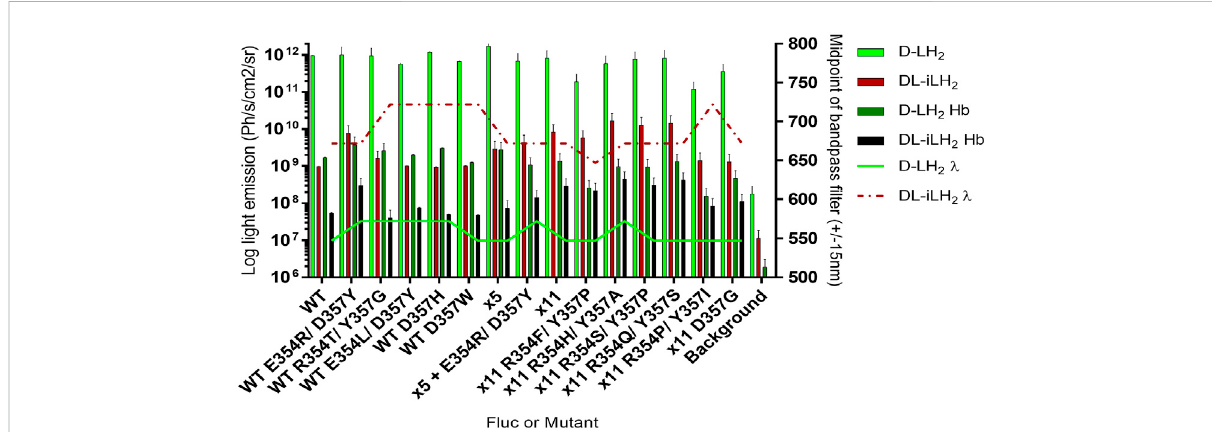
FIGURE 5 Activity of puri fi ed Flucs and mutants with both substrates. Speci fi c activity and emission peak wavelengths of selected R354 and/or D357mutantsofWT,x5,andx11Flucs.150 μ M D -LH 2 or15 μ M DL -iLH 2 and2 mMATPwereusedtosaturate0.167and0.0167 μ MFlucs,respectively, and light emission was captured using the PIO. The assay was then repeated with the blood